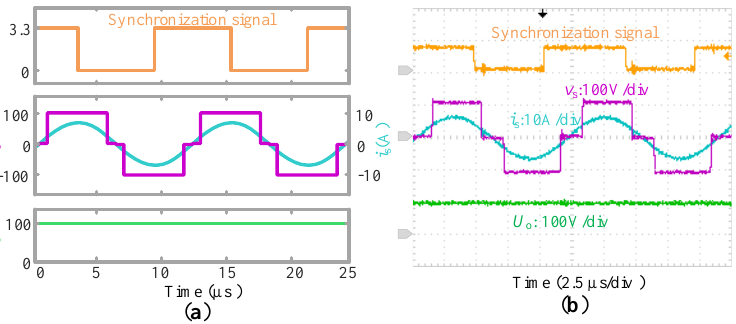
Figure 10. Typical waveforms of DPC receiver: ( a ) simulated; and ( b ) experimental. Synchronization signal (yellow lines); i s , secondary resonant current (blue lines); v s , secondary resonant voltage (purple lines); U o , output voltage (green lines).